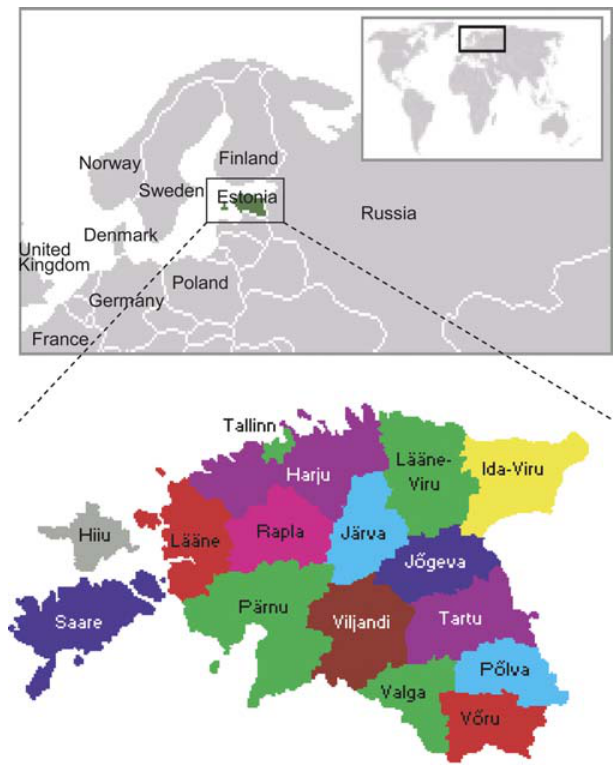
Figure 1. Map of Estonia DOI: